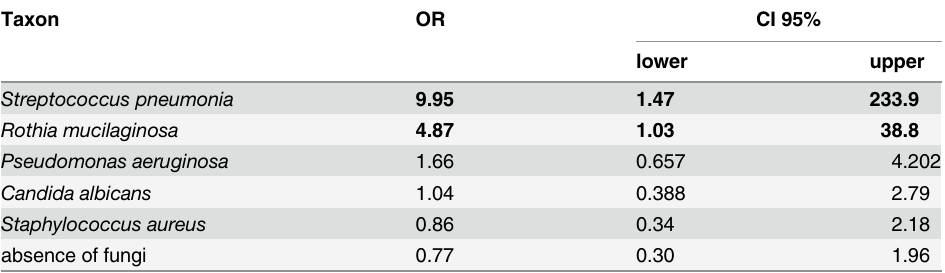
Table 2. Odds ratio from culturable microflora with differential occurrence in SD and S patients. Taxon OR CI 95% lower upper Streptococcus pneumonia 9.95 1.47 233.9 Rothia mucilaginosa 4.87 1.03 38.8 Pseudomonas aeruginosa 1.66 0.657 4.202 Candida albicans 1.04 0.388 2.79 Staphylococcus aureus 0.86 0.34 2.18 absence of fungi 0.77 0.30 1.96 Data report the taxa detected from Principal Component Analysis (Fig 1), the odds ratio (OR) of association between presence of the taxa and SD status, the 95% con fi dence intervals (CI 95%). Statistically signi fi cant ORs are reported in bold.